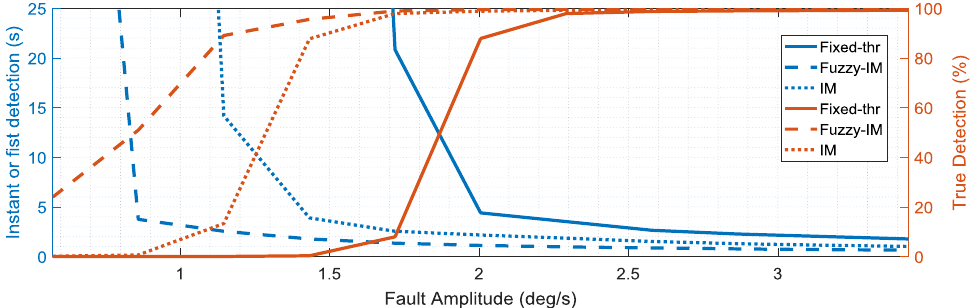
Figure 14. FD performance indexes for the q ( k ) sensor as function of the fault amplitude (mean values evaluated for the four validation flights).